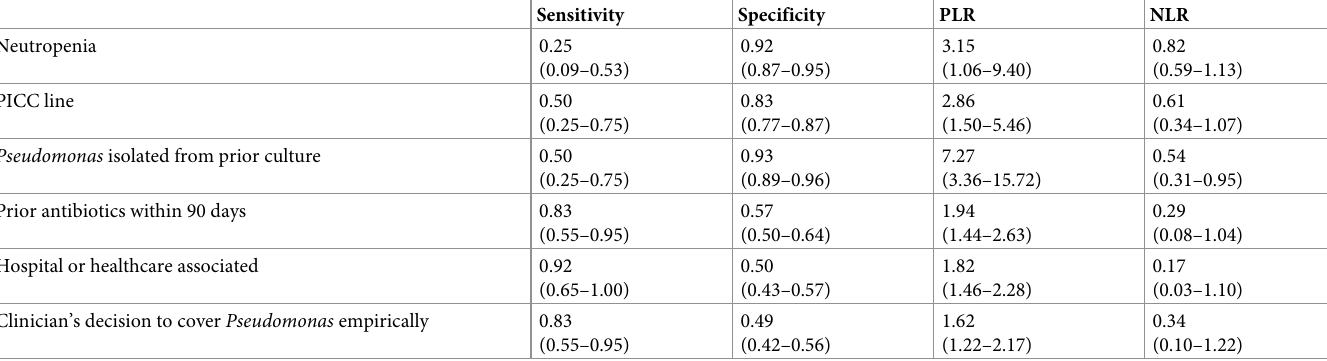
Table 6. Diagnostic accuracy of patient risk factors and clinician’s decision on empiric Pseudomonas coverage in predicting Pseudomonas